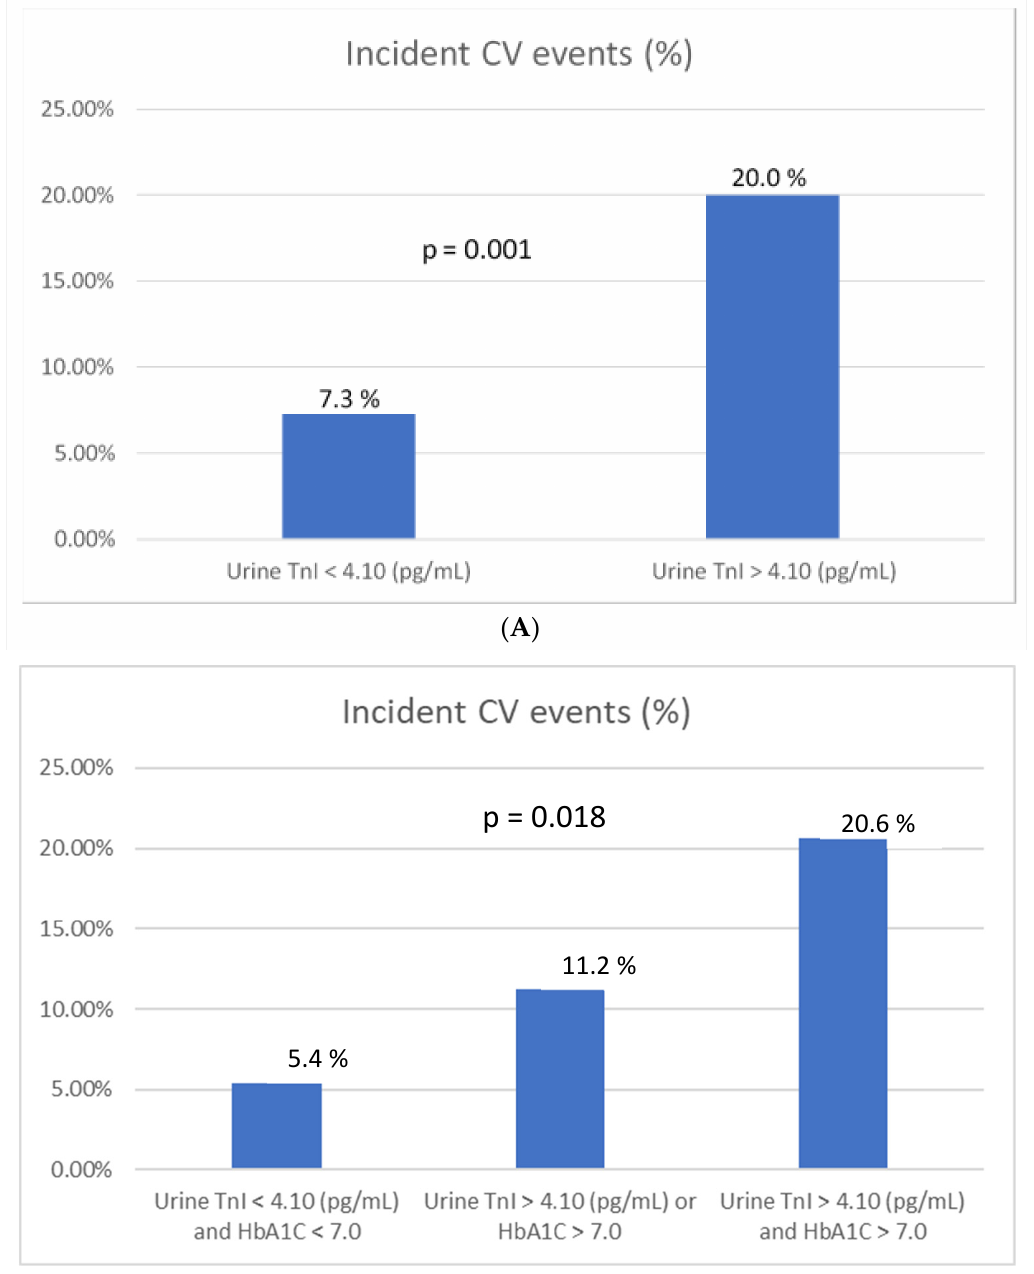
Figure 1. Frequency of subsequent incident cardiovascular (CV) events according to the urine high-sensitivity troponin I (hs-TnI) concentration and HbA1C level. ( A ) The percentage of patients with subsequent incident CV events was significantly higher in those with a hs-TnI concentration > 4.10 pg / mL; ( B ) the percentage of patients with subsequent incident CV events was significantly higher in those with a hs-TnI concentration > 4.10 pg / mL and HbA1C > 7.0